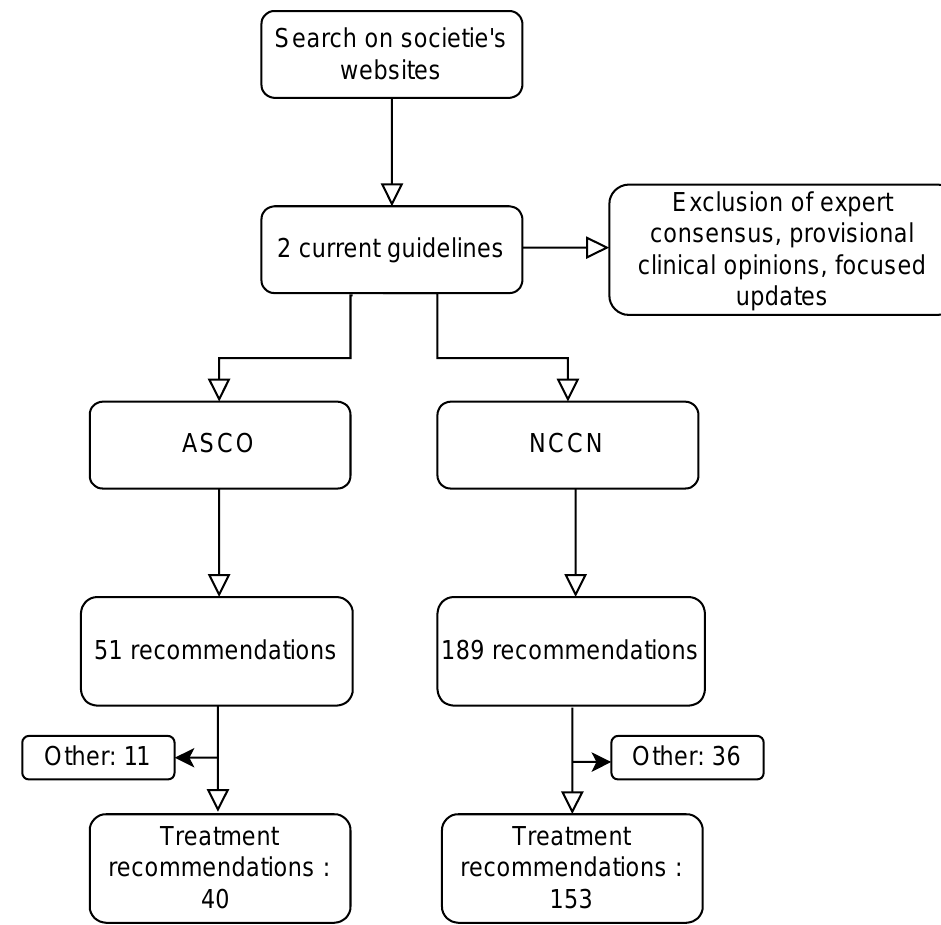
Figure 1. Flow chart of the search for current guidelines and their therapeutic recommendations. ASCO: American society of clinical oncology, NCCN: national comprehensive cancer network. “Other” includes non-therapeutic recommendations on incidence and epidemiology, diagnosis and staging, and